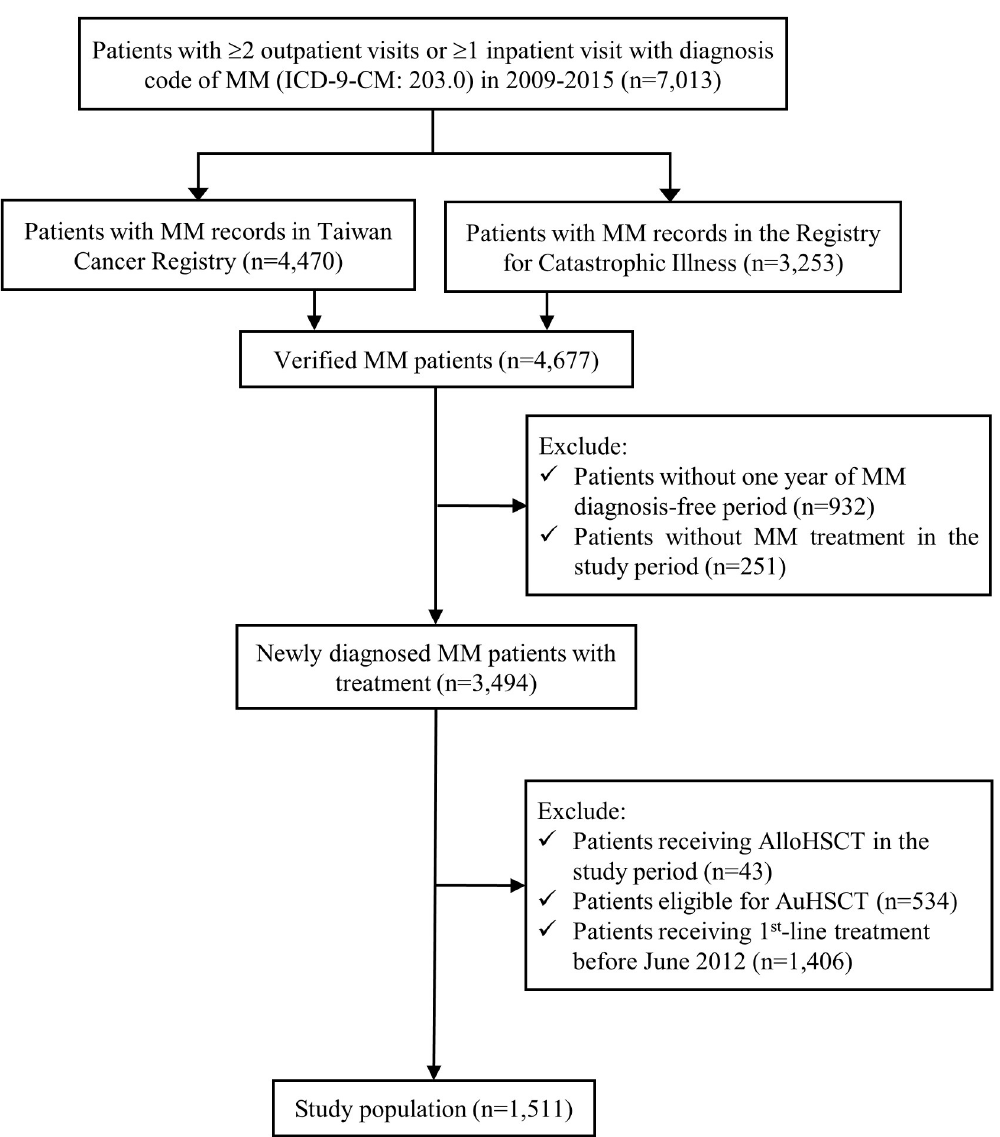
Fig 1. Flow chart of study population selection. AlloHSCT = allogeneic hematopoietic stem cell transplantation; AuHSCT = autologous hematopoietic stem cell transplantation; MM = multiple myeloma.